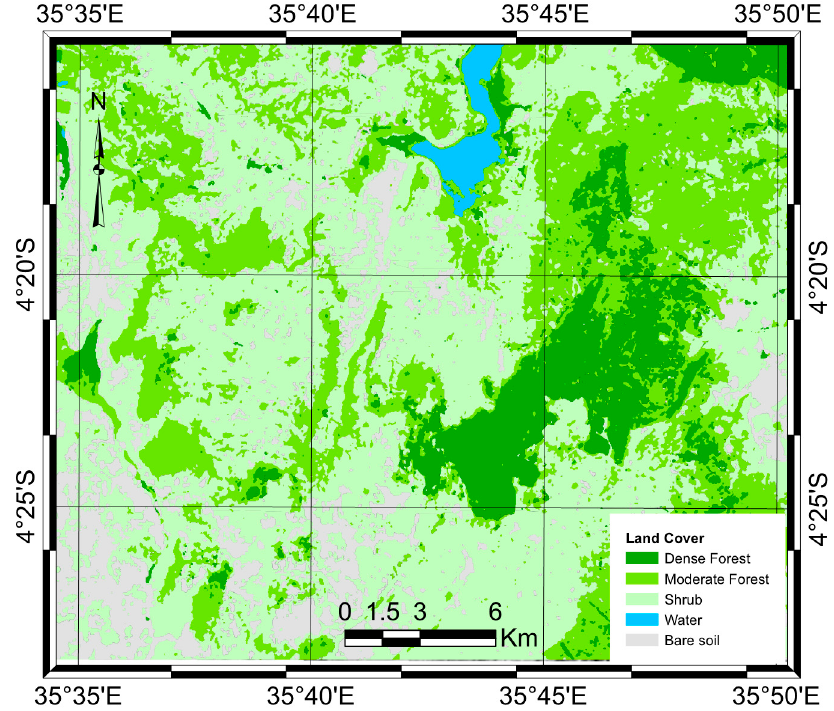
Figure 8. Land cover map produces based on integration of Landsat TM and ALOS PALSAR data.